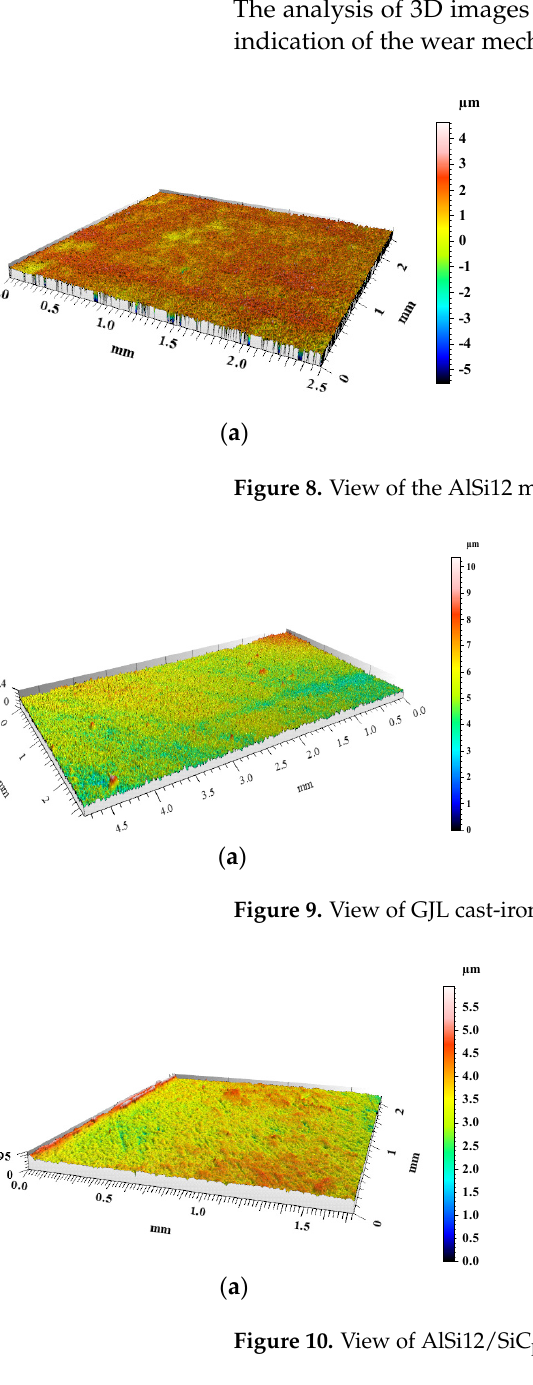
( a ) ( b ) Figure 11. View of AlSi12/GC p composite surface geometry: ( a ) before and ( b ) after dry friction test. ( a ) ( b ) Figure 12. View of AlSi12/SiC p + GC p hybrid composite surface geometry: ( a ) before and ( b ) after dry friction test. Based on the 3D images (Figures 8–12), it can be concluded that all tested materials showed abrasive wear. However, there were significant differences in its intensity that can be compared due to the selected parameters. To evaluate the changes in surface ge- ometry due to friction, the basic roughness parameters were used, including the arithmet- ical mean roughness value ( Ra )—calculated as the arithmetical mean of the absolute val- ues of the profile deviations from the mean line of the roughness profile, and ( Sa )—arith- metical mean surface height (Figure 13), as well as the average depth of the wear trace (Figure 14).